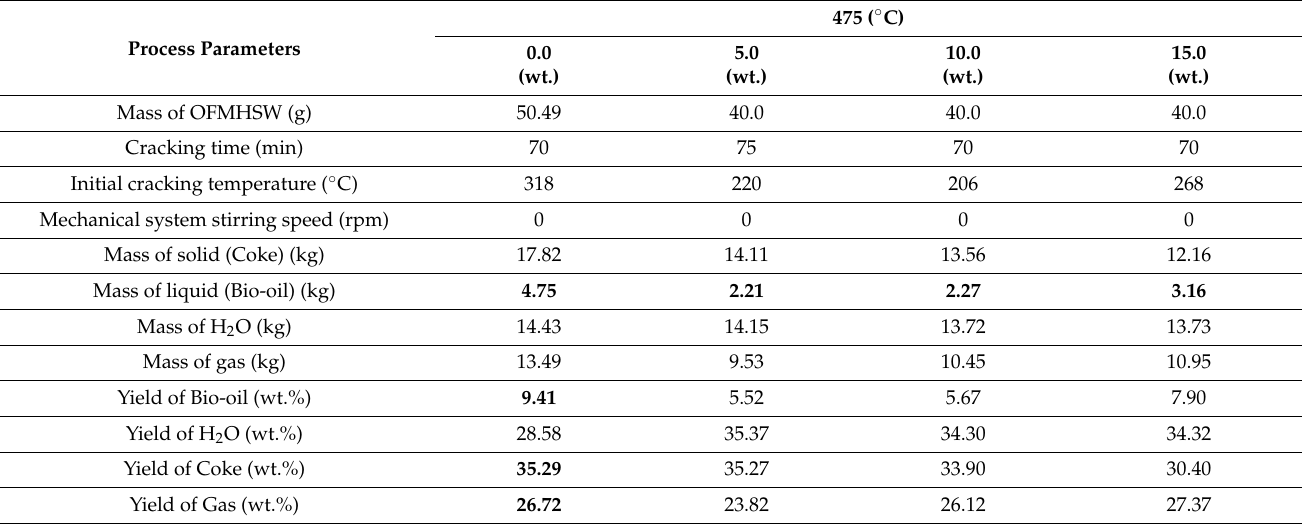
Table 10. Process parameters, mass balances, and yields of reaction products (liquids, solids, H 2 O, and gas) by thermal catalytic cracking of MHSW fraction (organic matter + paper) at 475 ◦ C, 1.0